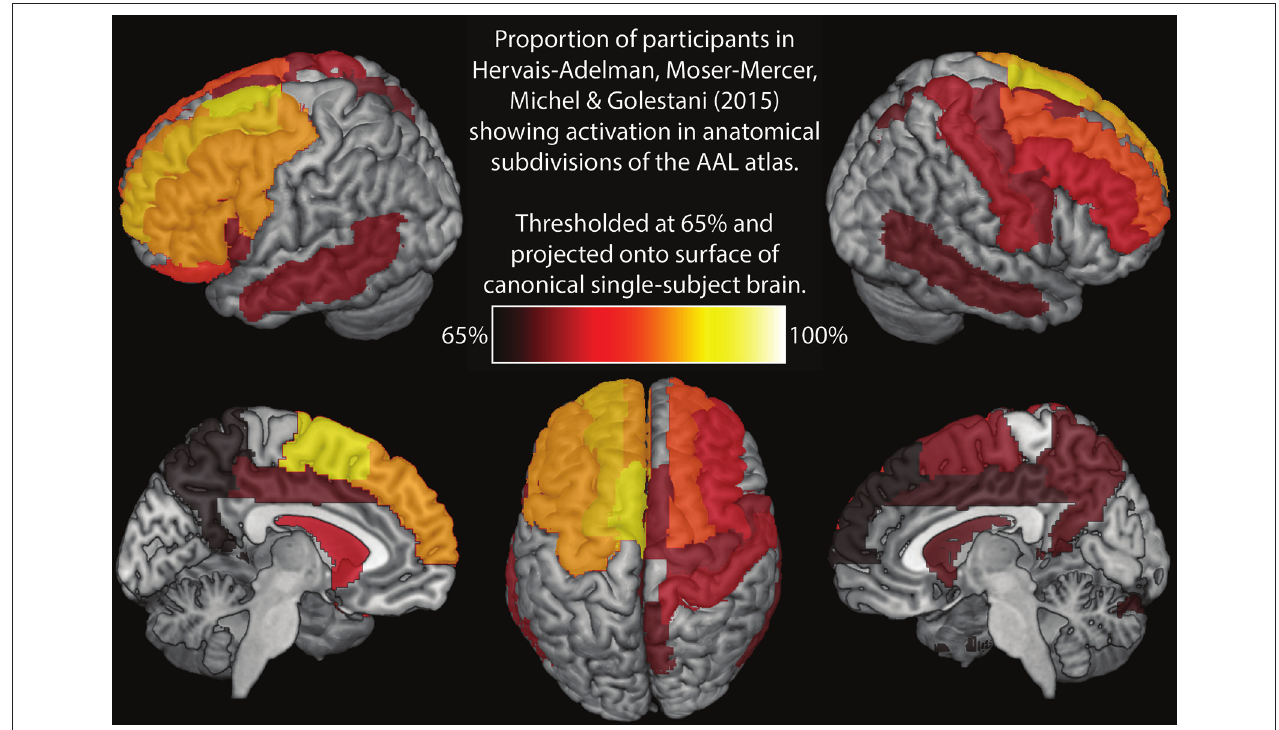
FIGURE 1 | Regions showing significant (at uncorrected p < 0.01) activation increase for interpreting vs. shadowing in at least 65% of participants in Hervais-Adelman et al.